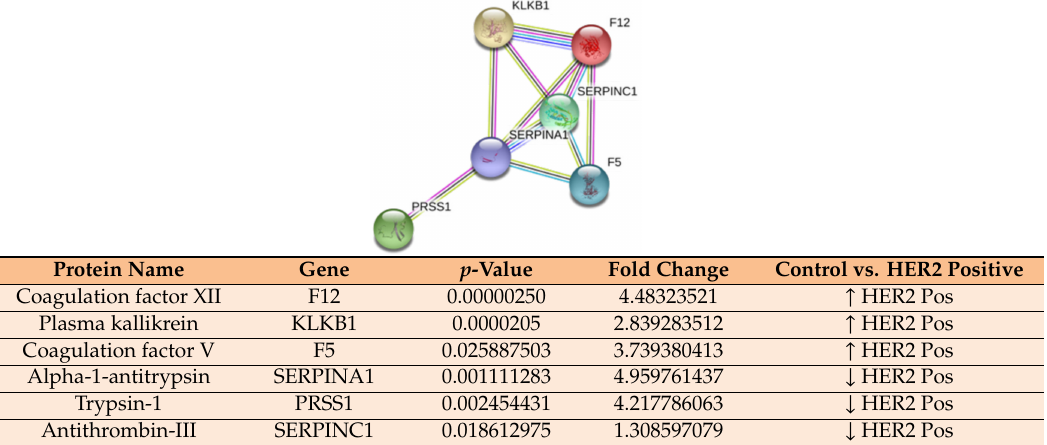
Table 3. Candidate deregulated blood coagulation biomarkers in HER2-overexpressing BC patients found after the proteomic analysis of the ex vivo corona-coated AuNPs. On the bottom, a cluster of blood coagulation proteins found in the protein–protein interaction network map of the genes encoded di ff erentially regulated proteins for the HER2-overexpressing BC patients found after the proteomic analysis of the ex vivo corona-coated